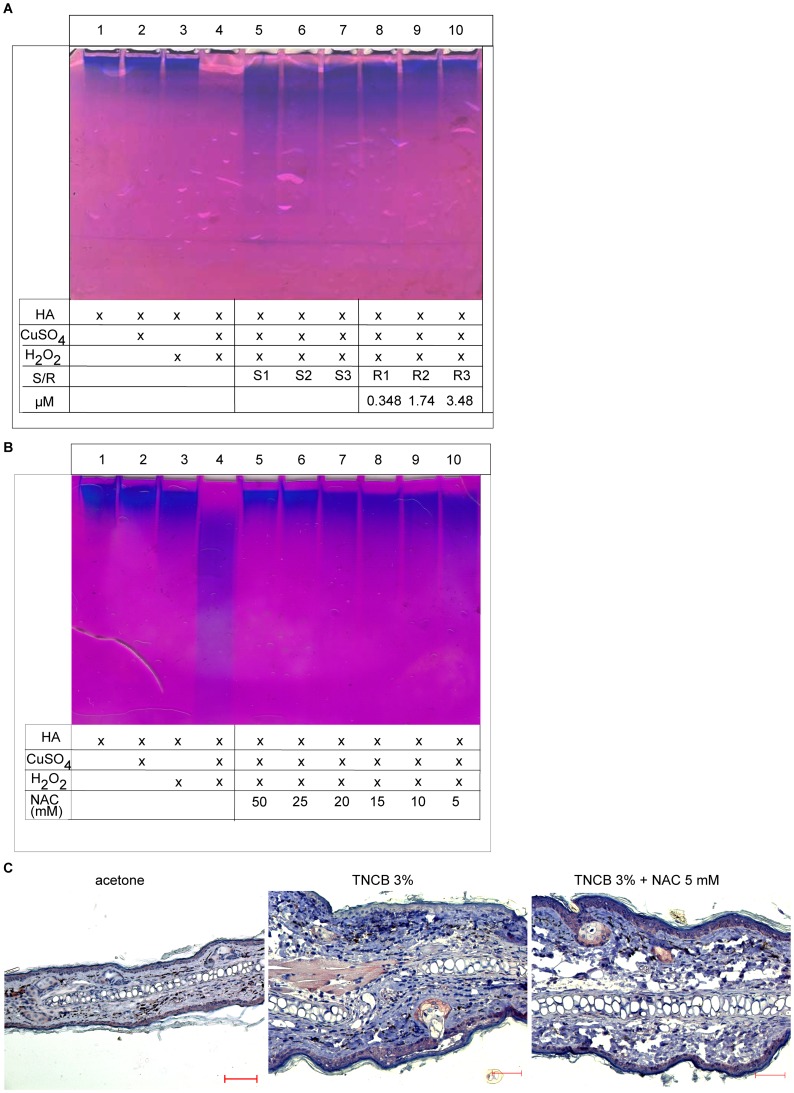
Antioxidant treatment inhibits HA degradation by ROS in vitro and in vivo.
(A) High molecular weight HA was incubated with ROS inducing compounds in combination with RF-40s (R) or solvent controls (S) at corresponding concentrations. MW of HA after incubation was analyzed by SDS gel electrophoresis and staining with Stains all. The untreated HA control is shown in lane 1, CuSO4 or H2O2 only treated HA controls are shown in lanes 2 and 3. One representative gel out of three is shown. (B) High molecular weight HA was incubated with ROS inducing compounds as in (A) with or without addition of different concentrations of the antioxidant NAC. MW of HA after incubation was analyzed by SDS gel electrophoresis and staining with Stains all. One representative gel of three is shown. (C) Staining of HA in murine ears treated topically with acetone, TNCB or TNCB and NAC on the back side of the ear skin (upper side in panels). Samples from ears were fixed as described and paraffin sections (3 µm) were stained with bHABP with subsequent AEC (3-Amino-9-ethylcarbazole) staining and haematoxylin counterstaining. HA is stained brown/red and cell nuclei in blue. Pictures are representative of three independent experiments with three mice each. Magnification = 200×; scale bars  = 50 µm.